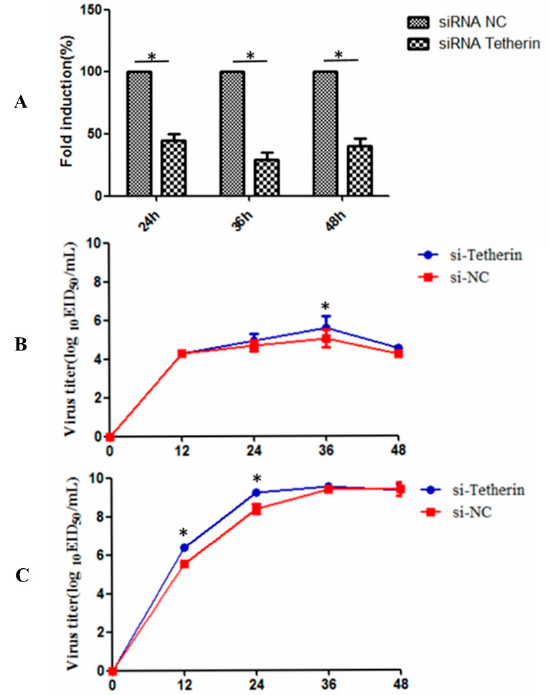
Figure 9. Interference with tetherin expression in MDCK cells. ( A ) Analysis of the effect of tetherin siRNA. The samples were measured in triplicate. The relative expression levels of tetherin mRNA were calculated according to the 2 − ∆∆ C T method; ( B ) replication and growth curves of CIV H3N2 in MDCK cells with silenced tetherin expression; ( C ) replication and growth curves of CIV H5N1 in MDCK cells with silenced tetherin expression. Each experiment was conducted three times independently and the data analysis was conducted in SPSS with an independent t-test. A p value less than 0.05 was considered statistically significant (* p < 0.05). The error bars represent the standard deviation.